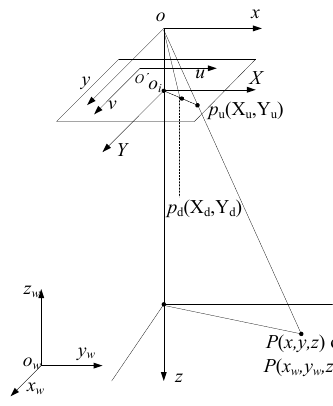
Figure 3. Principle of the perspective projection and camera model.